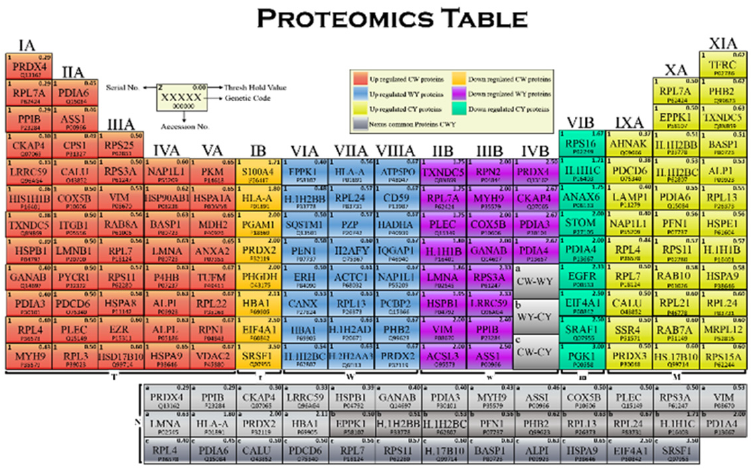
Figure 4. Proteomics table providing quantitative analysis of all differentially expressed proteins in CW, CY and YW groups.